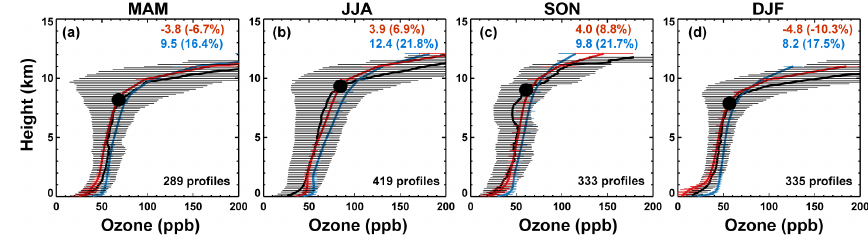
Figure 8. Similar to Fig. 7 but for seasonal profiles at Frankfurt from the MOZAIC program.